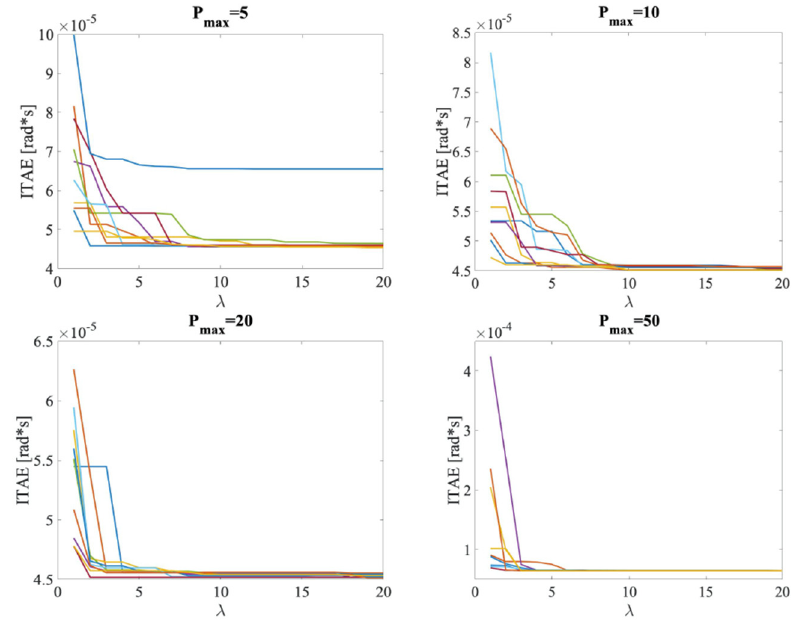
Figure 12. Integral of time absolute error (ITAE) vs. λ at the flutter speed.